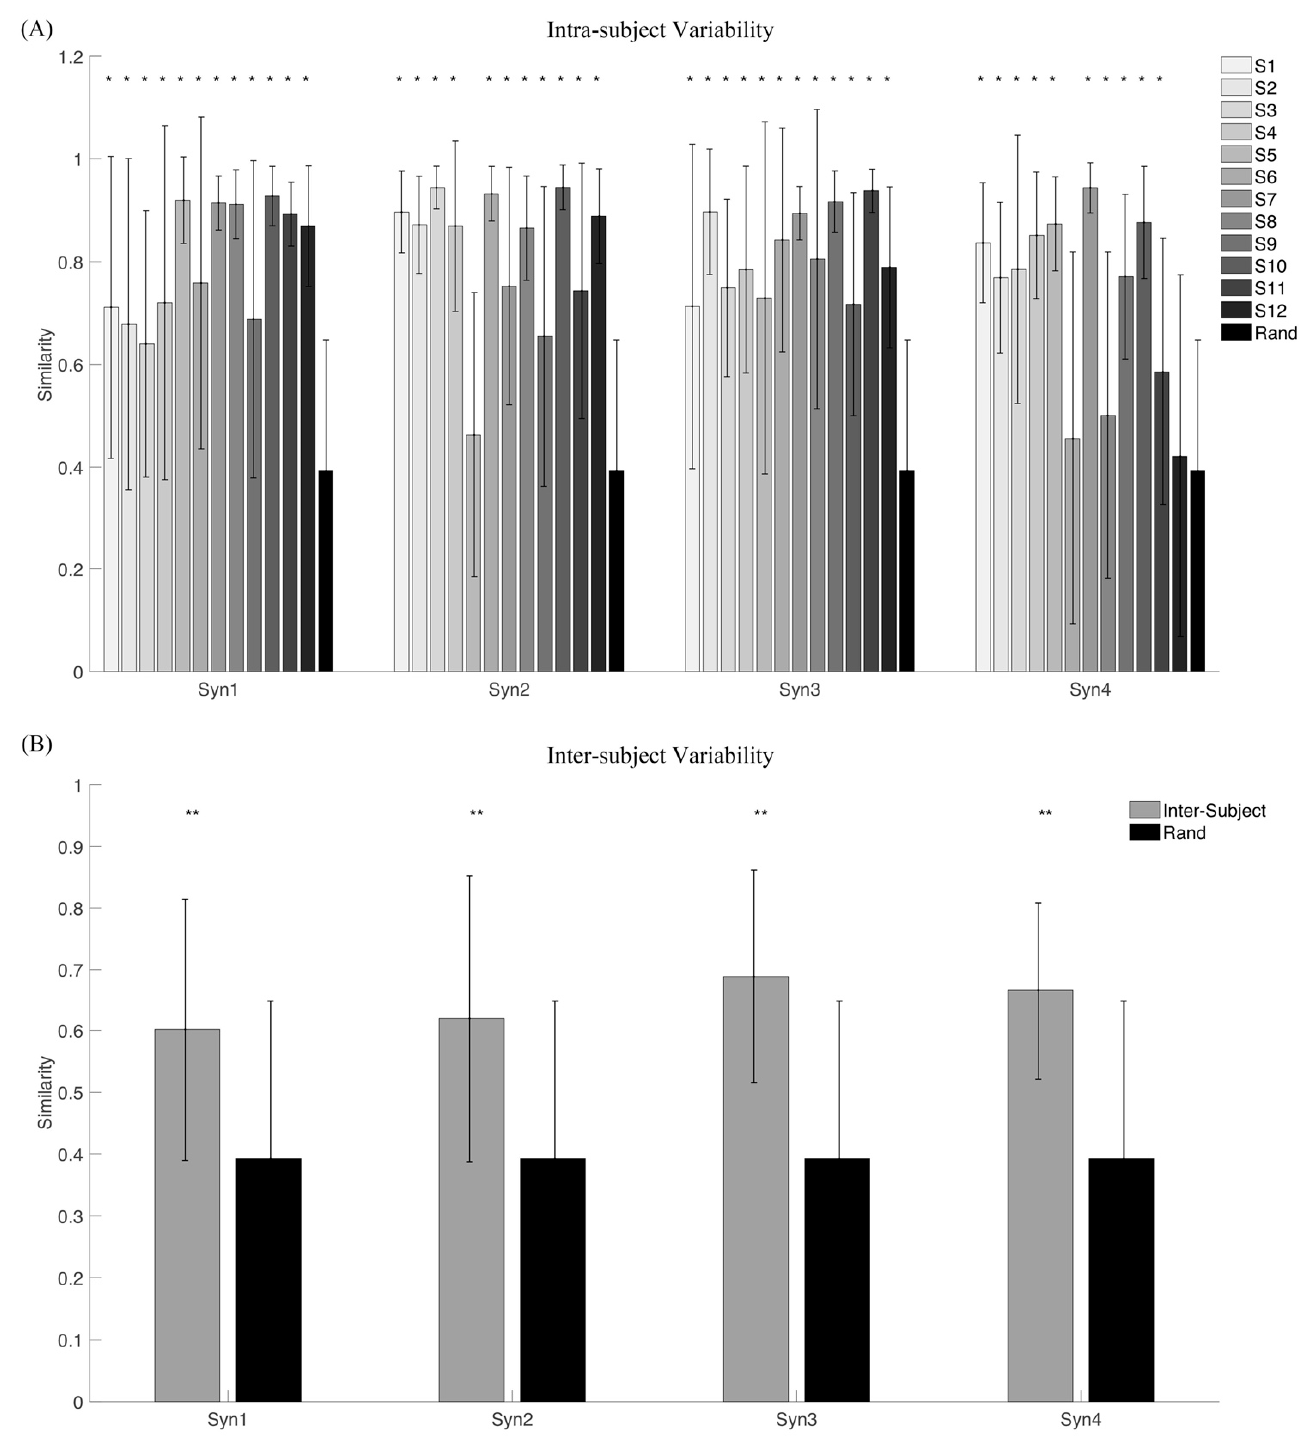
Figure 9. Synergy vectors similarity for intra-subject ( A ) and inter-subject ( B ) conditions. ( A ) Each colored bar indicates the average similarity of synergy vectors across repetitions of each subject. The black line is the standard deviation. Four synergies were extracted for each subject. The final bar, “Rand”, represents matchings for the random similarity. ( B ) The average of the synergy matrix across repetitions is used to analyze the variability of inter-subject. Moreover, the synergies extracted from all repetitions and all subjects are pooled together to compute the random similarity of the synergy matrix. ** indicates significance level is lower than 0.001, and * lower than 0.05.